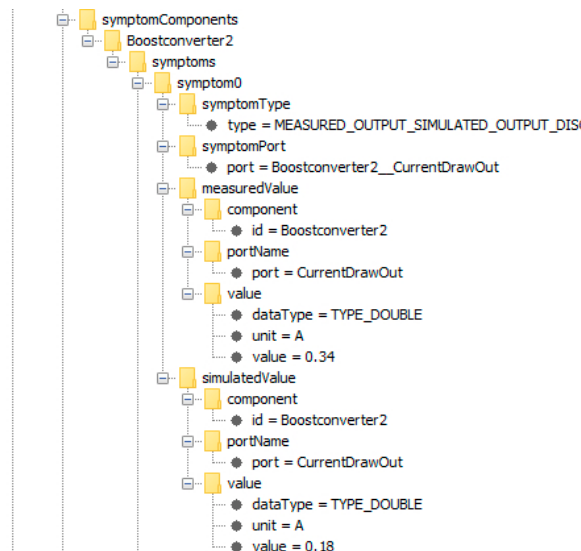
Figure 21. Fully expanded symptom of Boostconverter2, showing the symptom type, the symptom port, as well as the measured and simulated values that have caused the corresponding discrepancy. The symptom component is Boostconverter2, the symptom port is CurrentDrawOut, and the symptom type is MEASURED_OUTPUT_SIMULATED_OUTPUT_DISCREPANCY, indicating that the symptom was caused by a discrepancy between the measured and the simulated output of symptom port CurrentDrawOut.